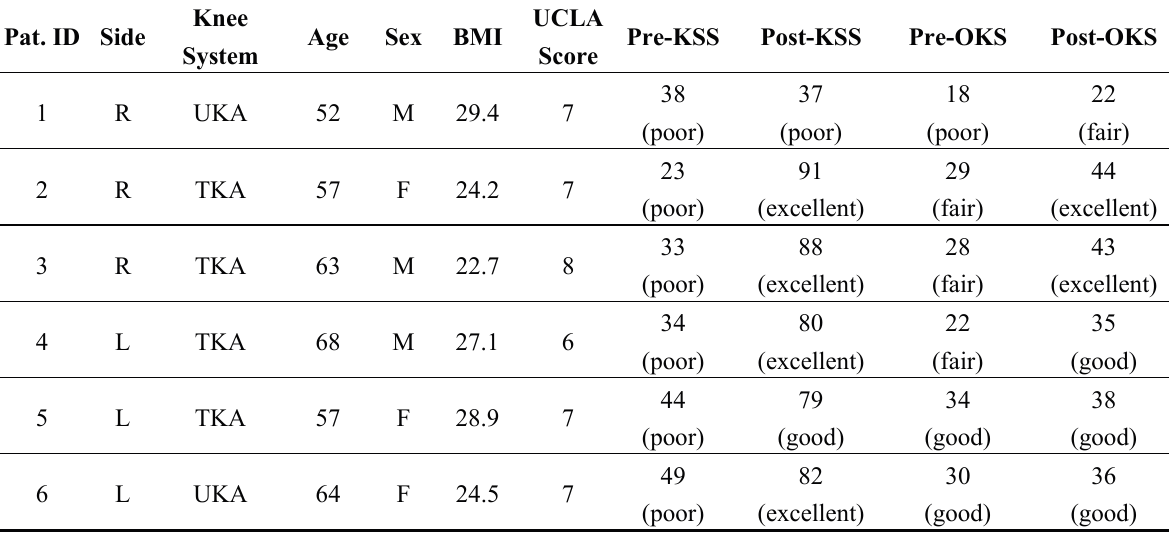
Table 1. Patients’ demographics and clinical outcome parameters/scores before (Pre) and 12 months after (Post) surgery.